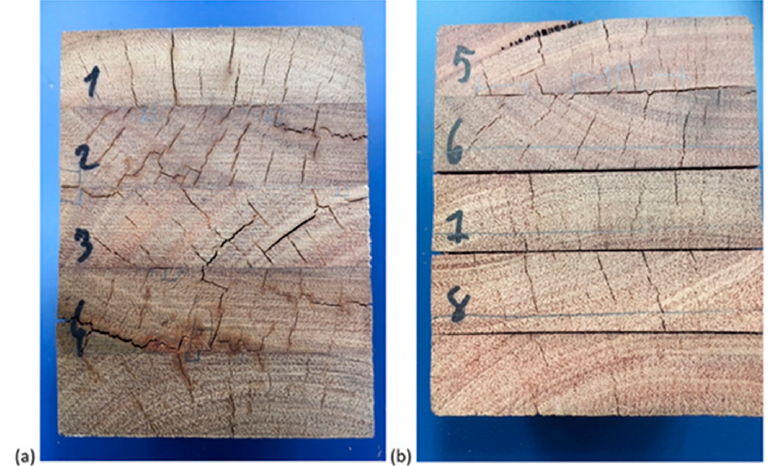
Figure 1. ( a ) Glulam sample that has passed the AS/NZS 1328.1:1998 [3] requirements; ( b ) Glulam sample that has failed the AS/NZS 1328.1:1998 [3] requirements, evidenced by the widespread delamination of all glue lines [8].